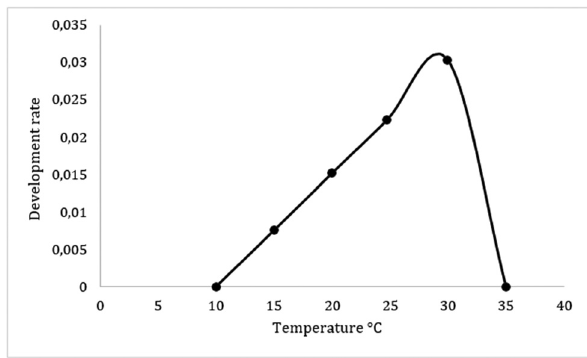
Figure 3: Development rate for D. busckella under di ff erent tem - peratures. Relationship between development rate and tempera - ture: 10°C – minimum development threshold; 30°C – optimum temperature; 35°C – maximum